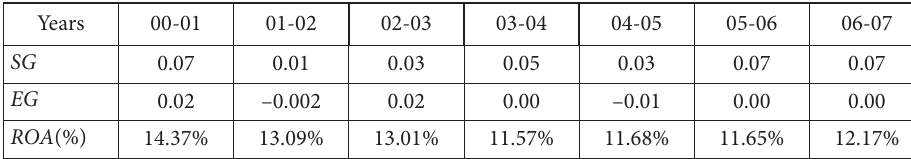
Table 3. Evolution of sales and employee growth and ROA from 2000 to 2014 (mean